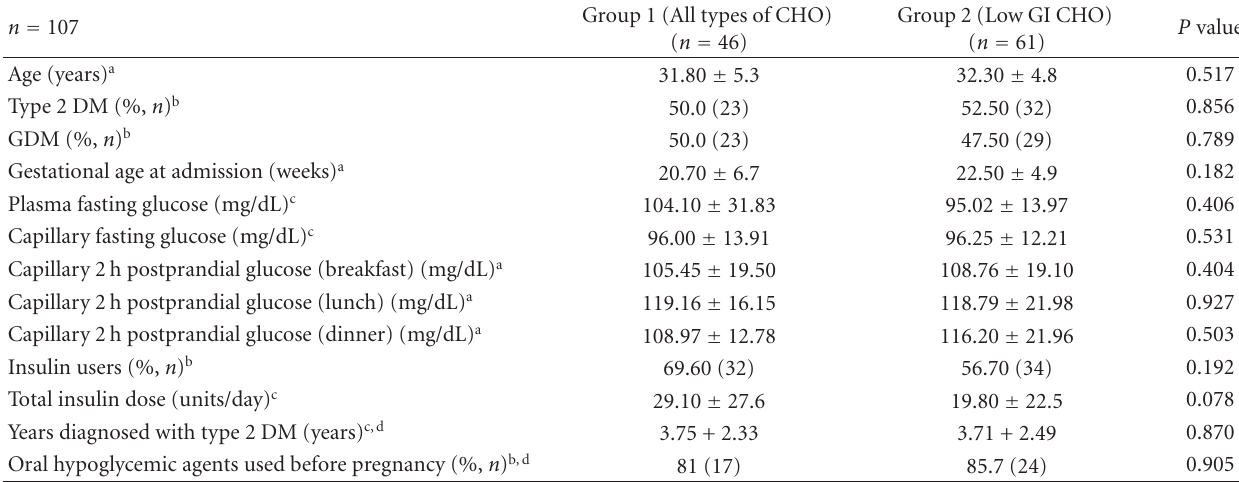
Table 1: Baseline personal, clinical, and glycemic data of pregnant women studied.